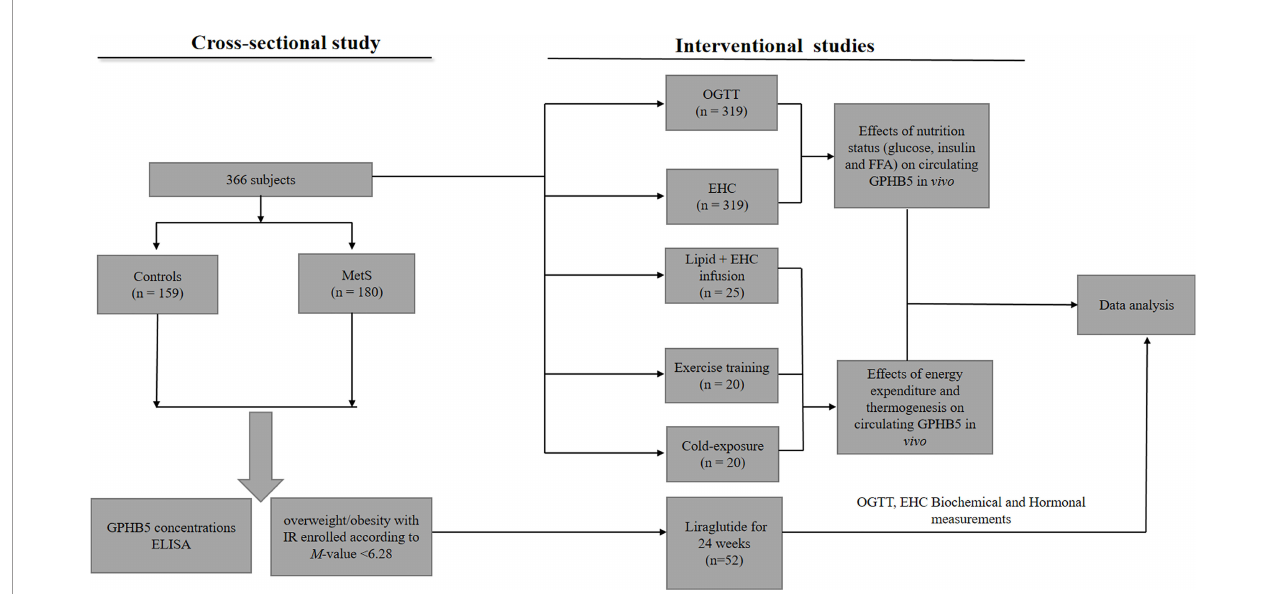
FIGURE 1 | Clinical experimental design. OGTT, oral glucose tolerance test; EHC, euglycemic-hyperinsulinemic clamp; MetS, Metabolic